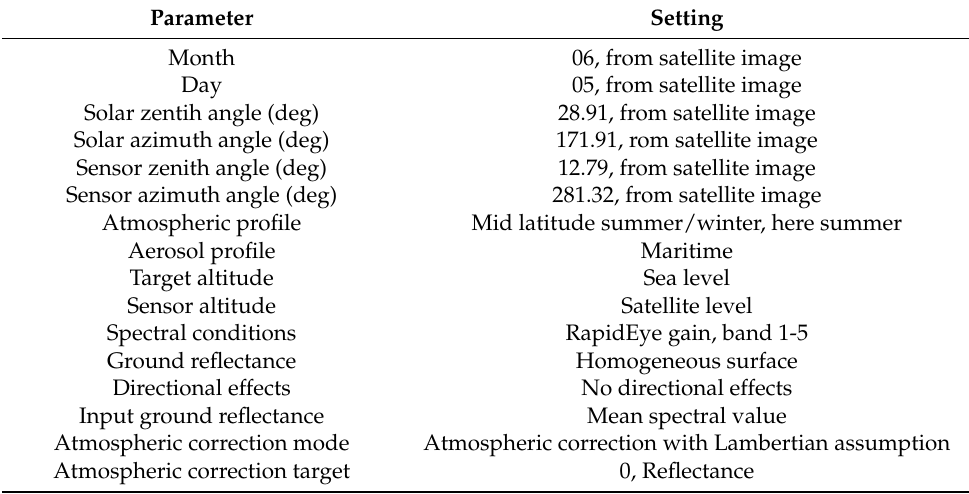
Table 2. 6S atmospheric correction model parameters used for the RapidEye atmospheric